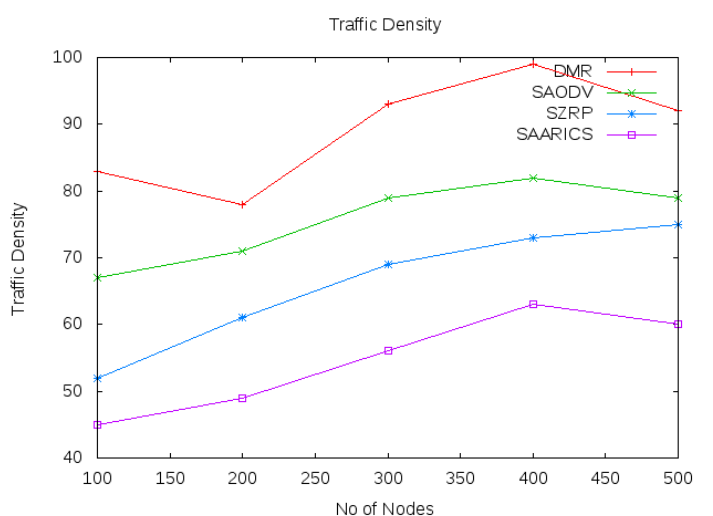
Figure 9. Traffic Density of Nodes.